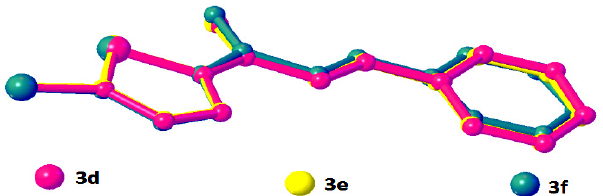
Figure 6. Overlay of compounds 3d , 3e and 3f excluding halogen substituents at benzene rings and H-atoms.